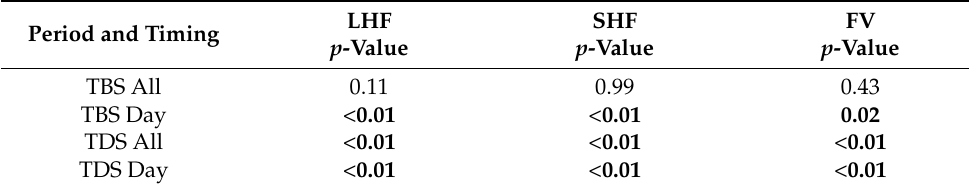
Table 3. Kruskal–Wallis test p -values for TBS and TDS when all hours ( n = 142) and daylight hours ( n = 81) are considered, bold signifies p -value < 0.05.